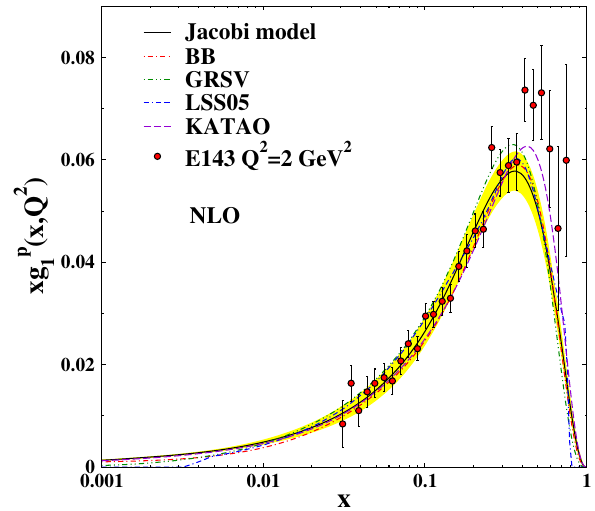
Fig. 2 The polarized proton structure functions as a function of x at Q 2 = 2 GeV 2 . The result of Jacobi expansion technique (solid curve) is compared with parametrization models like BB (dashed-dotted) [61], GRSV (dashed-dotted-dotted) [119], LSS05 (dashed-dashed-dotted) [120] and KATAO (dashed)